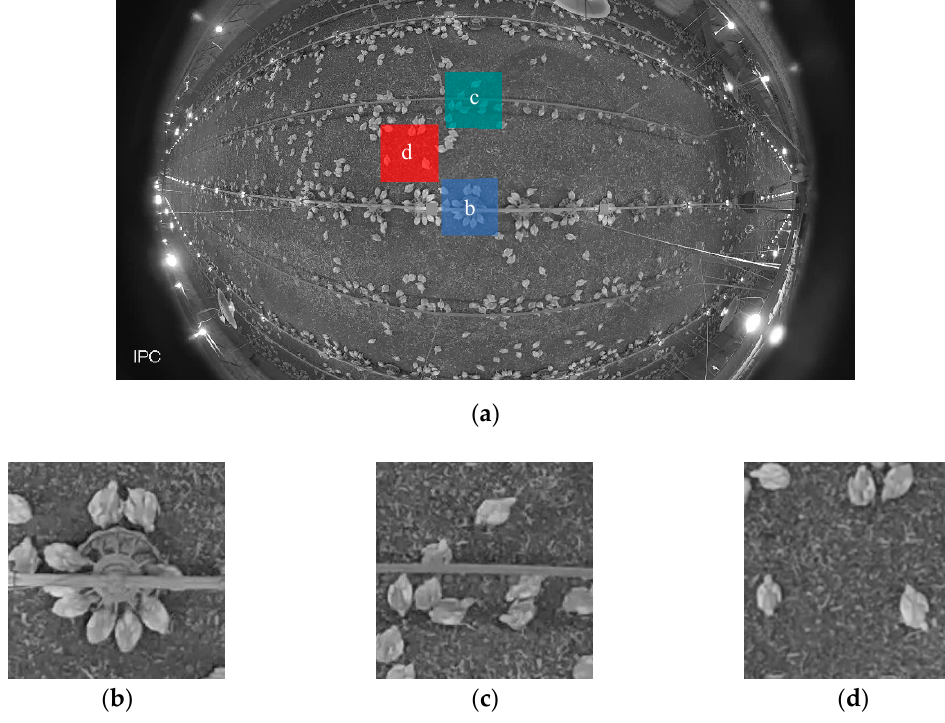
Figure 1. Example images of ( a ) original image ( b ) feeder ( c ) drinker and ( d ) open area.